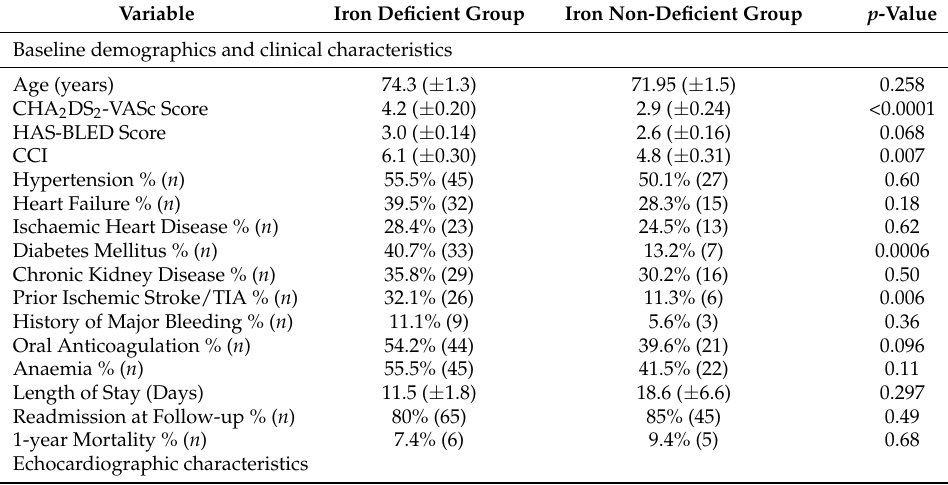
Table 2. Comparison of iron deficient and non-deficient